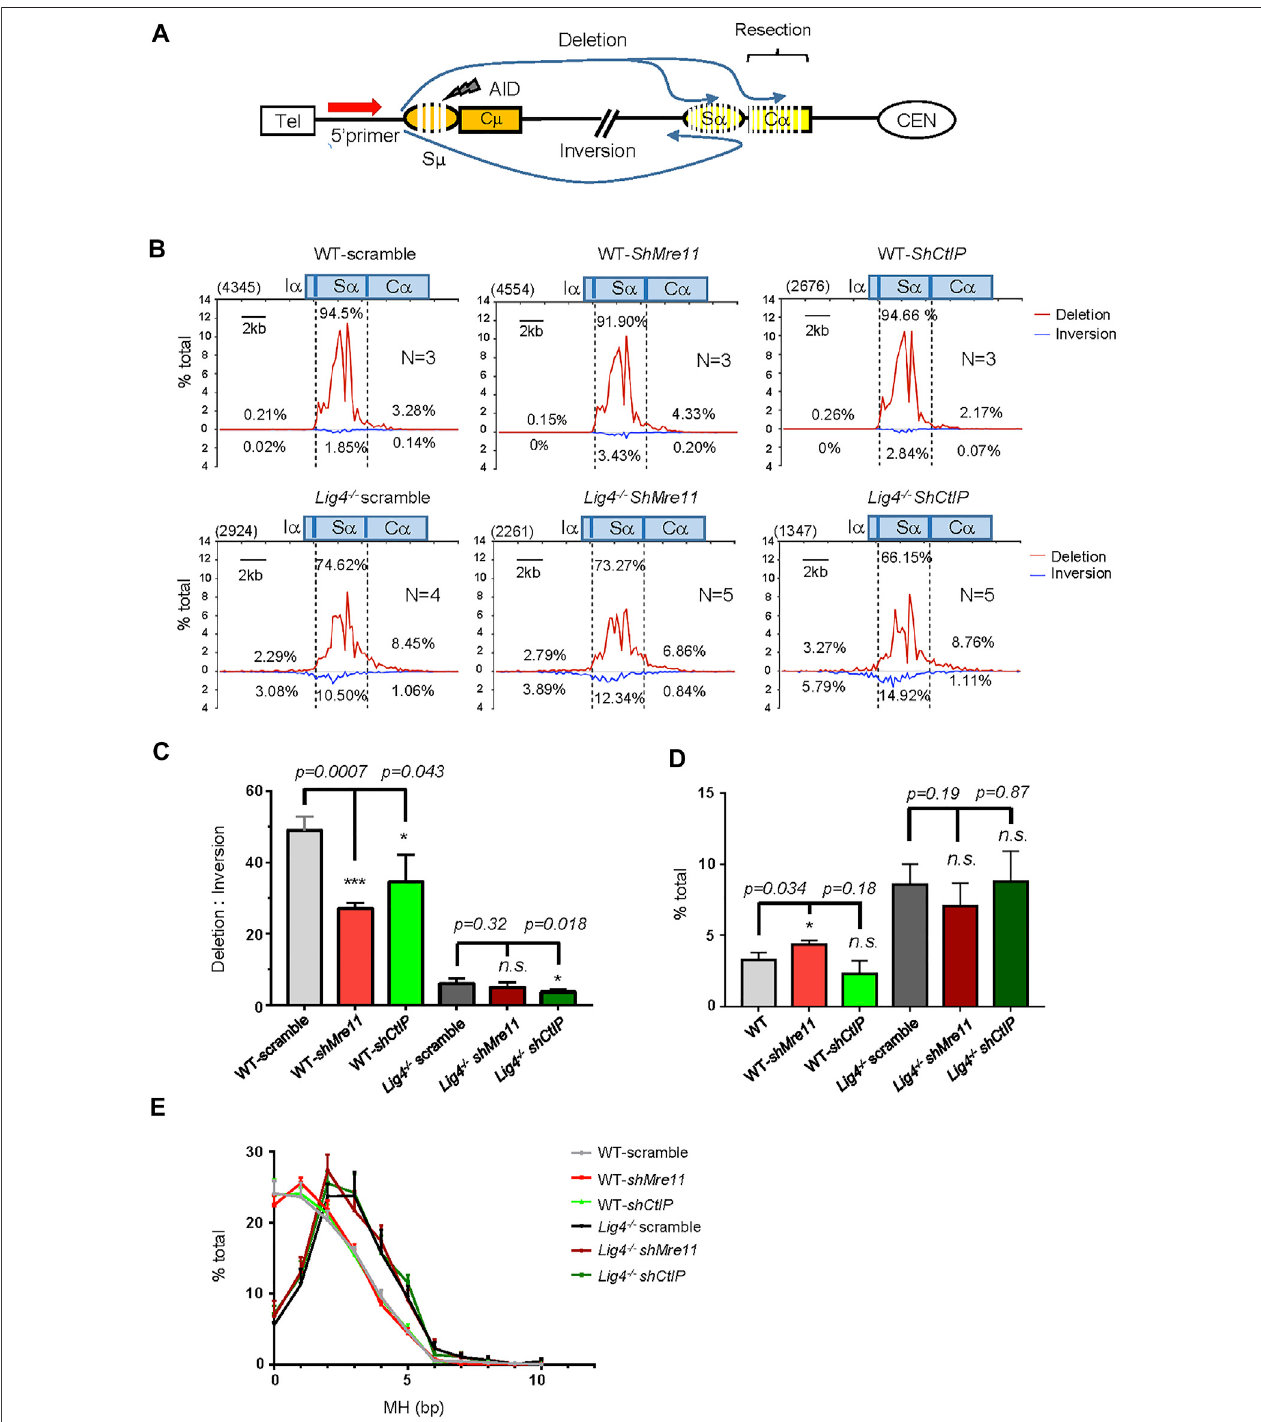
FIGURE2| S-Sjunctionpro fi leandMHusagepatterninMre11/CtIP-silencedWTand Lig4 − / − cells. (A) DiagramofthejoiningoutcomesbetweenS μ andS α DSB sequenced by HTGTS. Joining from 5 ′ S μ bait DSB to S α broken end reading in the telomere to centromere orientation are designated as deletion and represent productive joining, whereas those from 5 ′ S μ to S α broken end reading from centromere telomereorientation are designated asinversion and represent non-productive joining. Junctions falling into distal C α region are denoted as long resection. (B) Linear distribution of pooled S μ -S α junctions recovered from Mre11/CtIP-silenced WT and Lig4 − / − cells with indicated numbers ( N ) of experiment repeats are shown in the form of deletion or inversion along a 20-kb region centered at core S α (Chr12: 114491001 – 114511000).Binsizeis200bpand100binsarepresentedineachplot.Numbersintheparenthesisrepresenttotaluniquejunctionsintheindicatedregion.